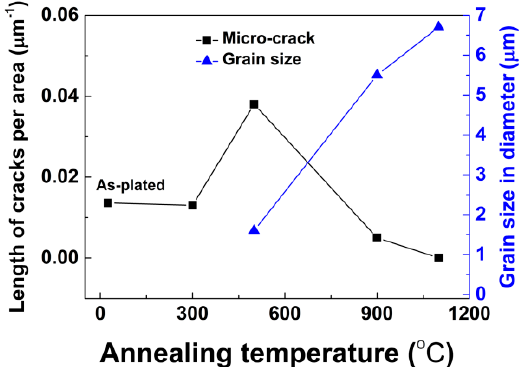
Figure 3. Micro-crack and grain size evolution of the Cr-coating with increasing annealing temperature.